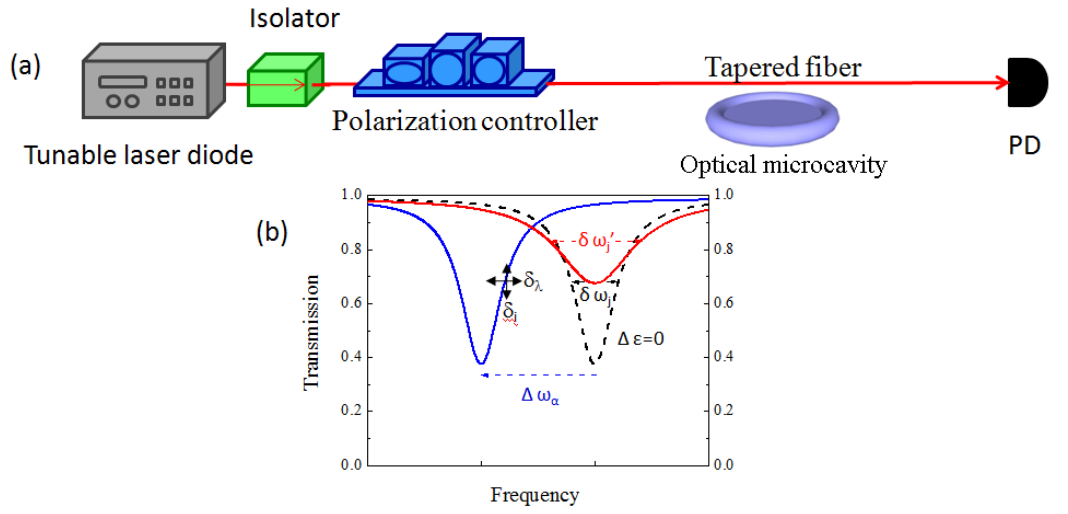
Figure 1. Microcavity optical sensing: (a) Optical sensing instrument example. Light from a tunable laser is coupled to a tapered fiber after isolator and polarization